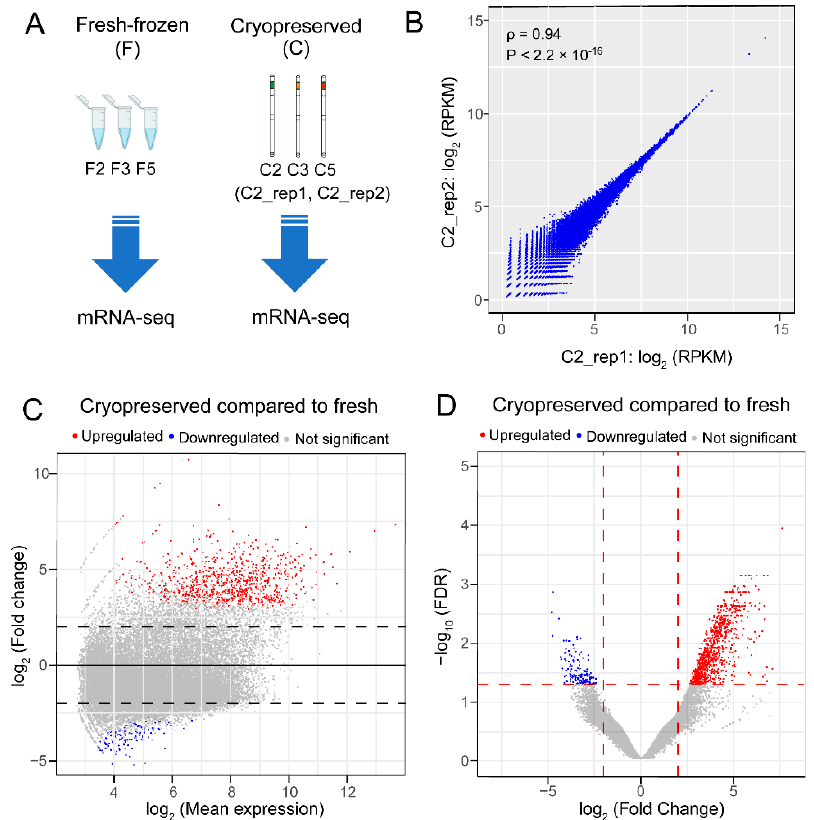
Figure 2. Transcriptome-wide identification of differentially expressed genes (DEGs) between the fresh-frozen and cryopreserved sperm in the blue catfish, Ictalurus furcatus . ( A ) RNA-seq samples were fresh-frozen (F) and cryopreserved (C) sperm samples from three males with ID numbers 2, 3, and 5. C2_rep1 and C2_rep2 are two technical replicates of the C2 sample. ( B ) Scatterplot of the log 2 (RKPM) values for C2_rep1 and C2_rep2. Spearman’s rank correlation coefficient ρ and the corresponding p -values are labeled. ( C ) MA plot of the comparison between fresh-frozen and cryopreserved sperm. Horizontal dash lines indicate |log 2 (fold change)| = 2, and DEGs are highlighted in red (upregulated) and blue (downregulated) dots. ( D ) Volcano plot of the comparison between fresh-frozen and cryopreserved sperm. The vertical dash lines indicate |log2(fold change)| = 2 and the horizontal line represents False Discovery Rate (FDR) < 0.05. Upregulated DEGs and downregulated DEGs were highlighted in red and blue, respectively.